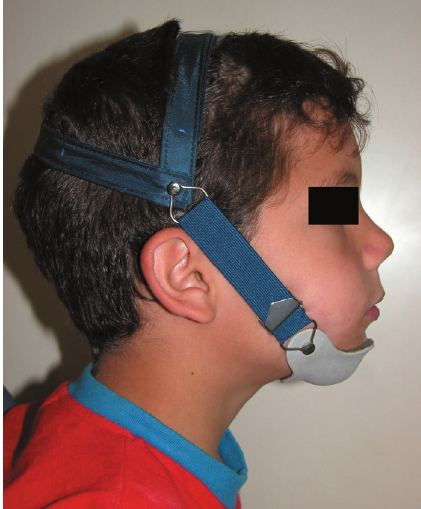
Figure 3- Chincup with the force vector directed to the